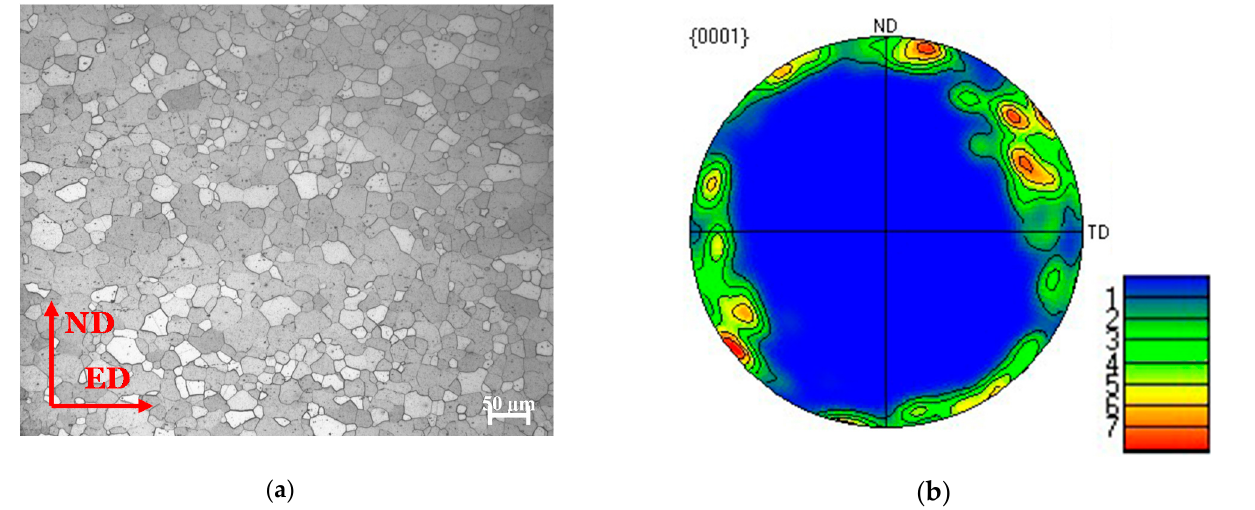
Figure 3. ( a ) The microstructure and ( b ) the pole figure of the as-extruded Mg-Al-Ca-Mn alloy.